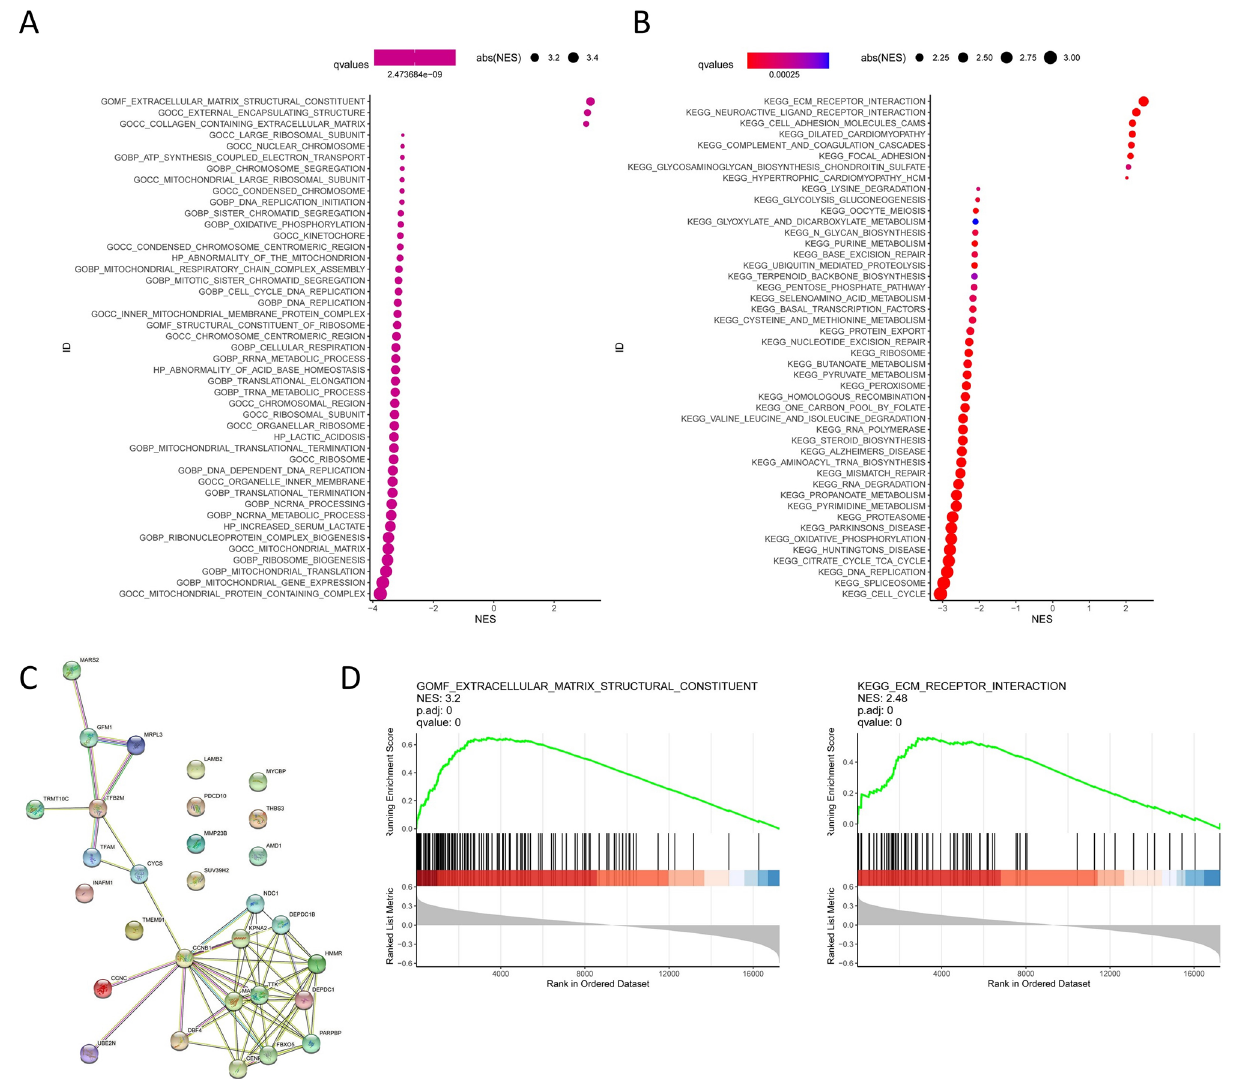
Figure 5. GO, KEGG, protein–protein interaction (PPI) network and GSEA analysis. ( A ) GO and ( B ) KEGG analysis of 10 mitophagy related genes. ( C ) PPI network of mitophagy related genes, revealing their intrinsic connections. ( D ) GSEA analysis of the mitophagy related genes between high and low risk